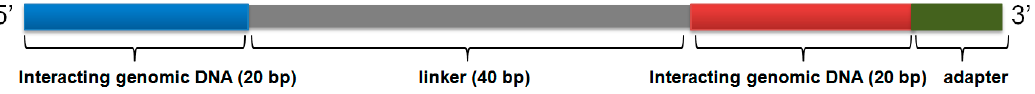
Figure 1. The schematic pipeline for the digestion-ligation-only Hi-C (DLO Hi-C) tool. The entire DLO Hi-C tool pipeline consists of four main steps, as four separate modules to process DLO Hi-C data. Boxes in dark gray indicate the filtered-out reads.